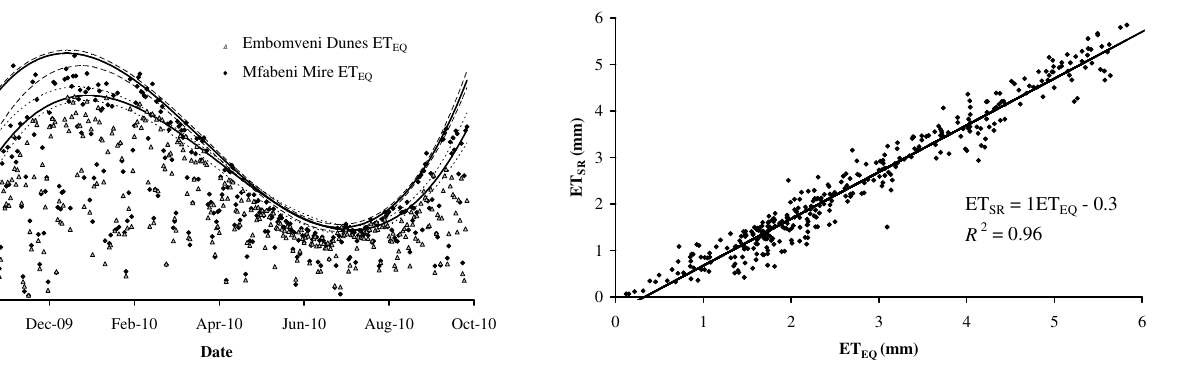
Fig. 11. The advective term ( α) at the Mfabeni Mire determined as the slope of the least squares linear regression of ET EQ vs. ET SR from October 2009 to September